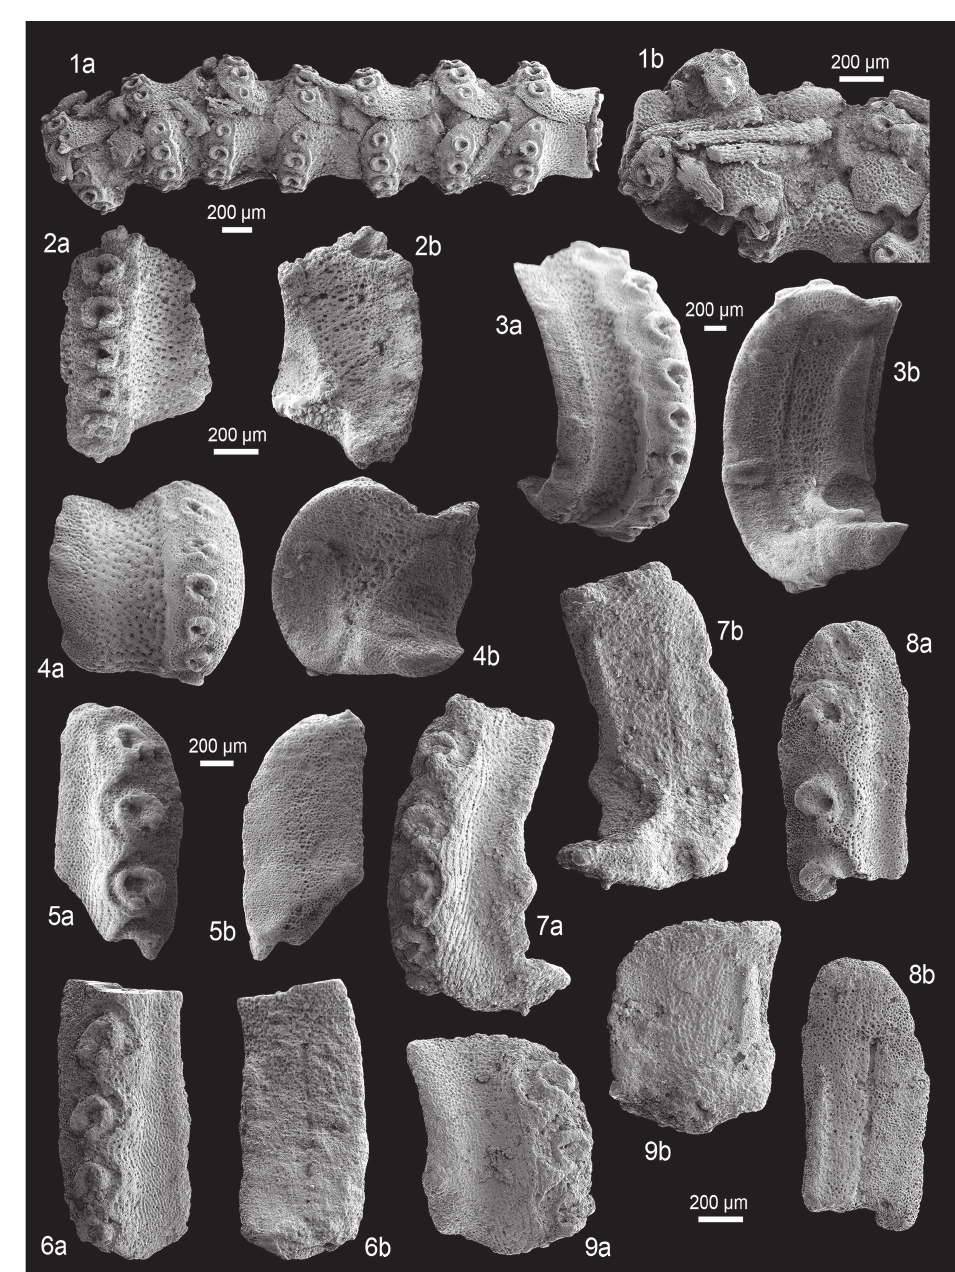
Fig. 21. Fossil lateral arm plates (LAPs) of ophiacanthid brittle stars in external (a) and internal (b) views and articulated arm fragment in ventral (a) and dorsal (b) views. 1. Ophiogaleus constrictus (Hess, 1966) comb. nov. from the late Oxfordian (Late Jurassic) of Savigna, France; GZG.INV.78627 distal arm fragment. 2. Ophiogaleus sp. from the early Kimmeridgian (Late Jurassic) of Geisingen, Germany; GZG.INV.78632, proximal LAP. 3-4. Ophiogaleus danicus (Rasmussen, 1952) comb. nov. from the early Maastrichtian (Late Cretaceous) of Rügen, Germany. 3. GZG.INV.78635, proximal LAP. 4. GZG. INV.78636, distal LAP. 5-6. Hanshessia sp. nov. innom. 1 from the late Sinemurian to early Pliensbachian (Early Jurassic) of the Glasenbach Gorge, Austria. 5. NHMW 2012/0137/0021, proximal LAP. 6. NHMW 2012/0137/0022, proximal LAP. 7-9. Hanshessia sp. nov. innom. 2 from the early Bathonian (Middle Jurassic) of La Pouza, France. 7. GZG.INV.78637, proximal LAP. 8. GZG.INV.78638, proximal LAP. 9. GZG.INV.78639, distal to median LAP. One common scale bar per species except for